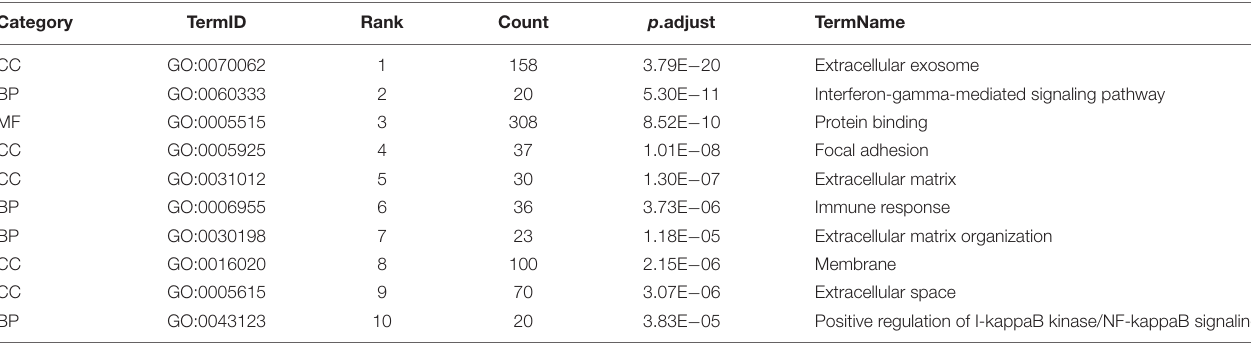
FIGURE 2 | (A) Module-trait relationships heatmap. Each row corresponds to a module eigengene (ME), and each column to a clinical trait. The correlation and p values are shown in the cells. (B) A scatterplot of gene significance (GS) for diabetic nephropathy (DN) versus module membership (MM) in the black. A highly significant correlation exists between GS and MM in the modules. TABLE 2 | Gene Ontology (GO) enrichment analysis of genes in black